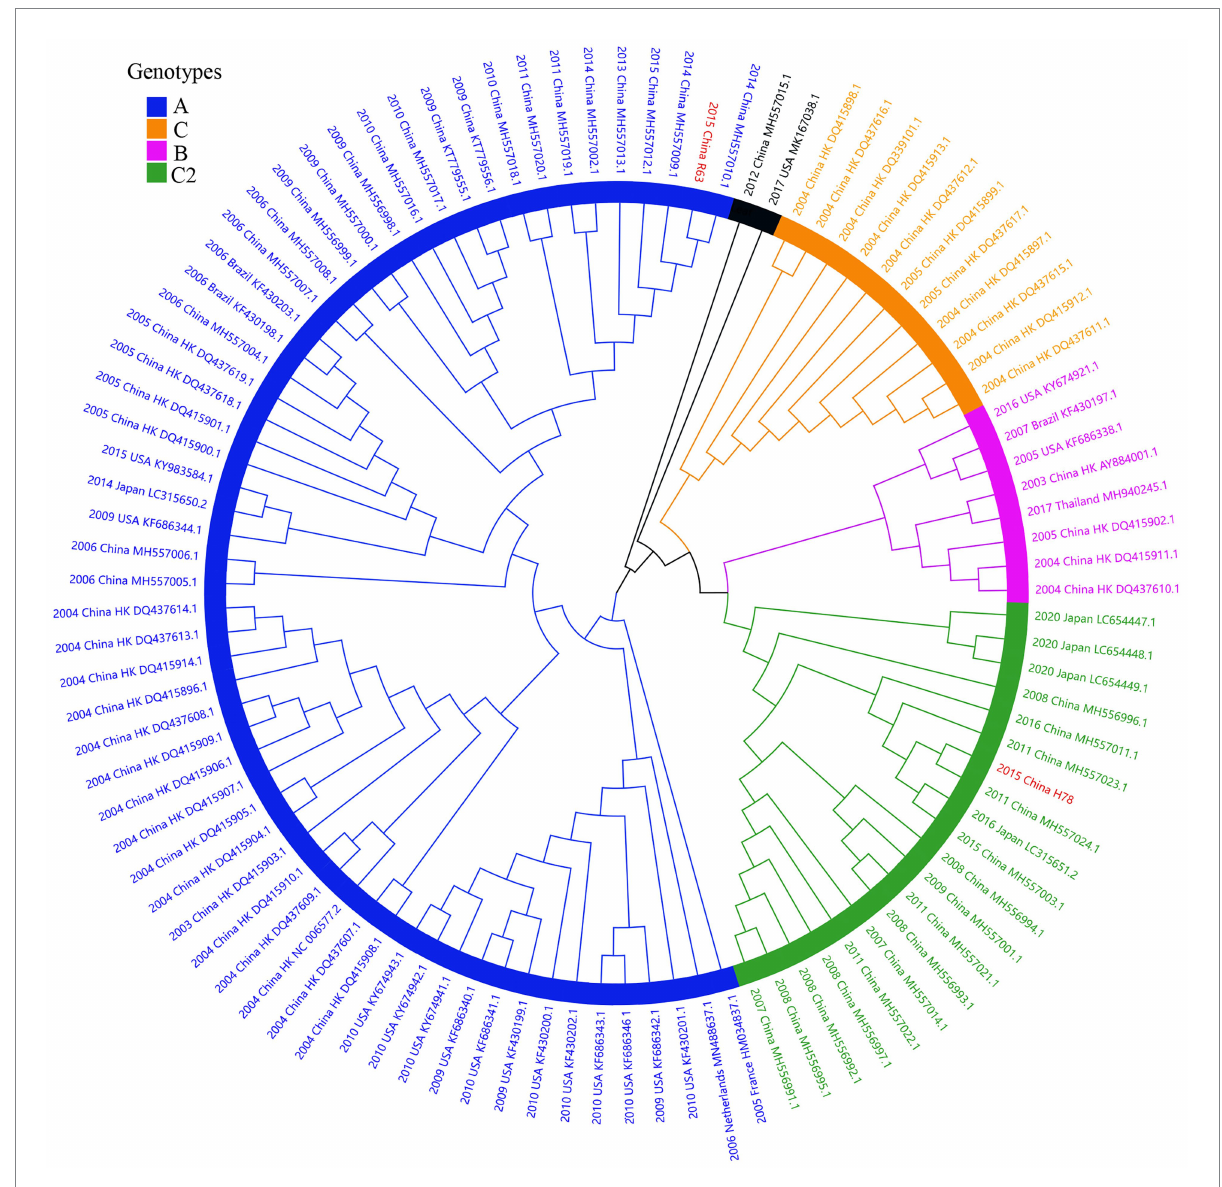
FIGURE 4 ML tree for the complete S gene of HCoV-HKU1. Different genotypes are distinguished by different colors and sequences obtained in this study are colored red. The year of sampling, city and accession number are at the tip labels. Phylogenetic analysis using MEGA v6.0 with 1,000 bootstrap